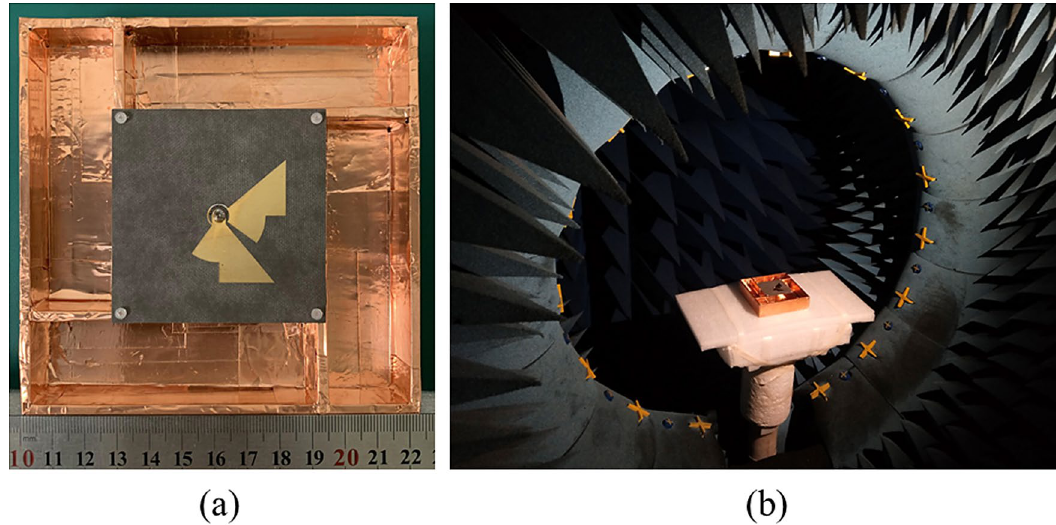
Figure 9. Photograph of the proposed antenna. ( a ) Top view of the proposed antenna. ( b ) The proposed antenna in Satimo system.